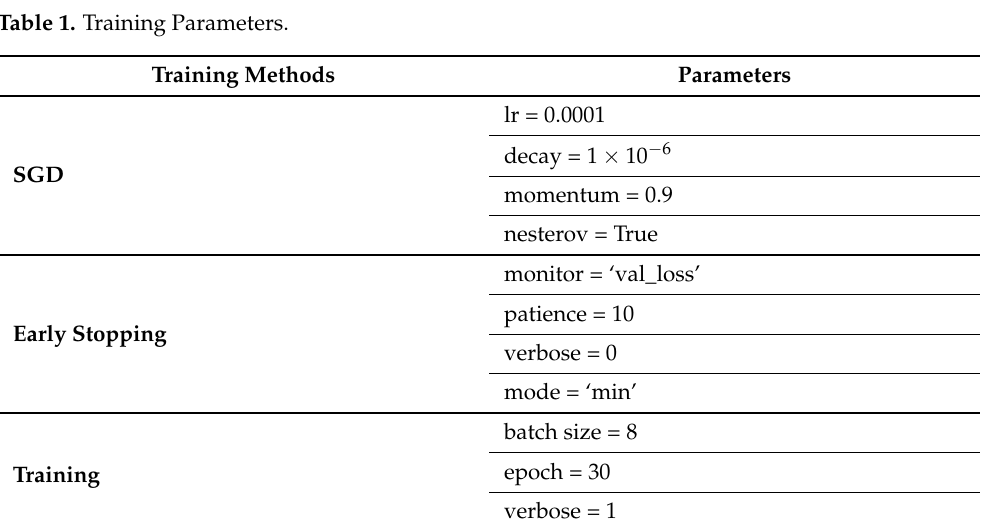
Table 1. Training